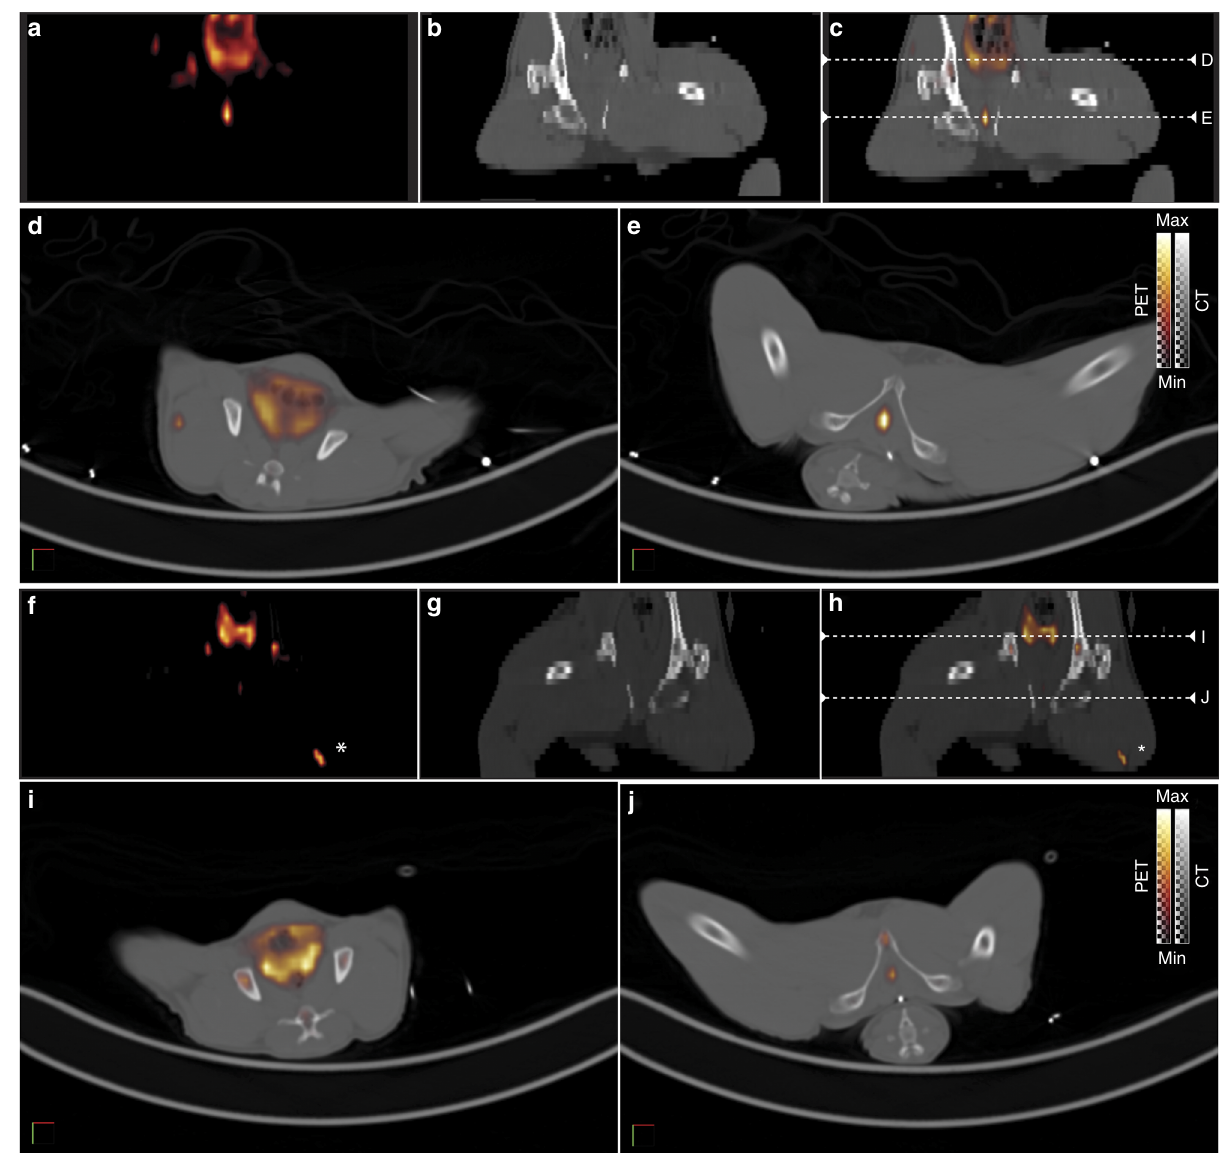
Fig. 6 hK2-target speci fi city is imaged in nonhuman primate using [ 89 Zr]hu11B6 PET/CT. Prostate localization of diagnostic anti-hK2 tracer, [ 89 Zr]hu11B6, imaged in a representative healthy adult male cynomolgous monkey (9 y.o.; 9.9 kg) at 8 d ( a – e ) and 16 d ( f – j ) post IV administration. ( a – c, f – h ) PET, CT and fusion coronal images showing the location of two axial planes (white dashed lines) for corresponding axial plane images of the prostate ( d , i ) and epididymis ( e , j ). Nonspeci fi c uptake at 16 d in left thigh ( f , h ) appears to localize to site of anesthetic administration (white